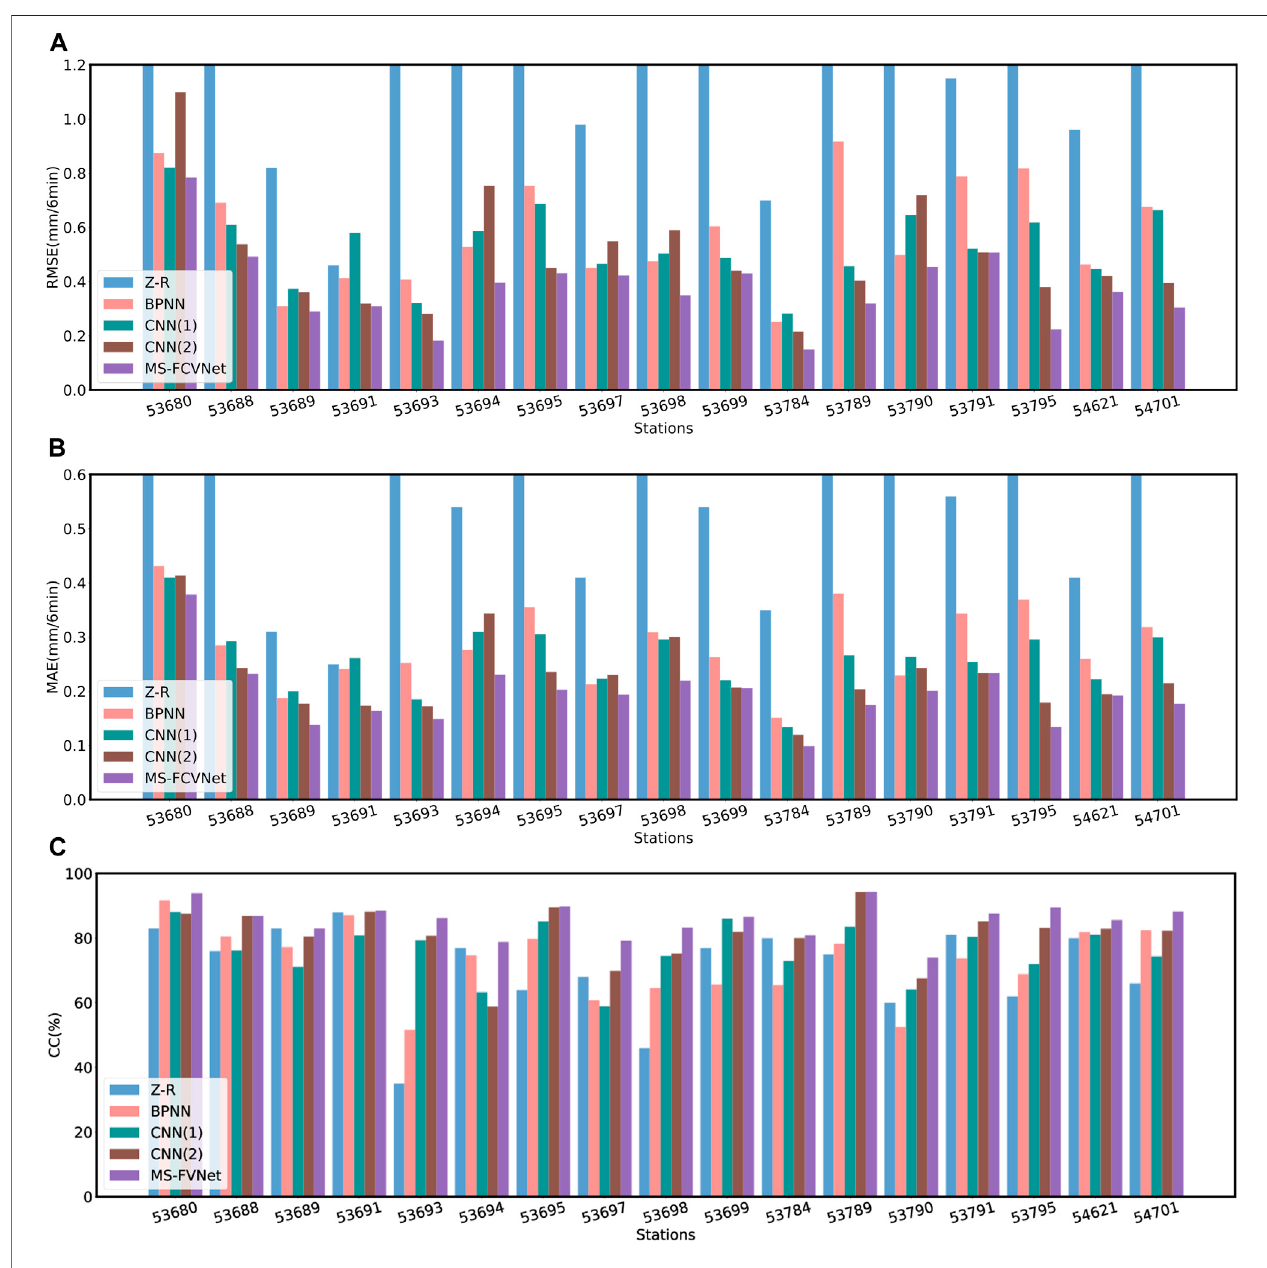
FIGURE 9 | MS-FCVNet scores for (A) RMSE, (B) MAE, (C) CC at 17 NWSs.